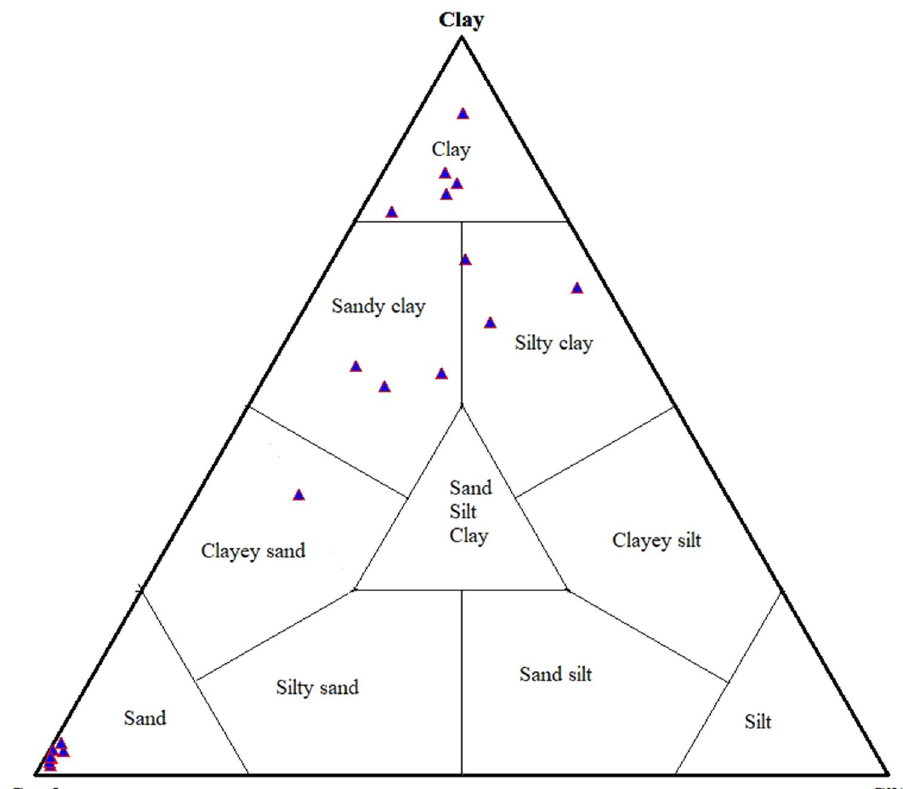
Fig. 2 Ternary plot showing the relative percentage of sand silt and clay particles of